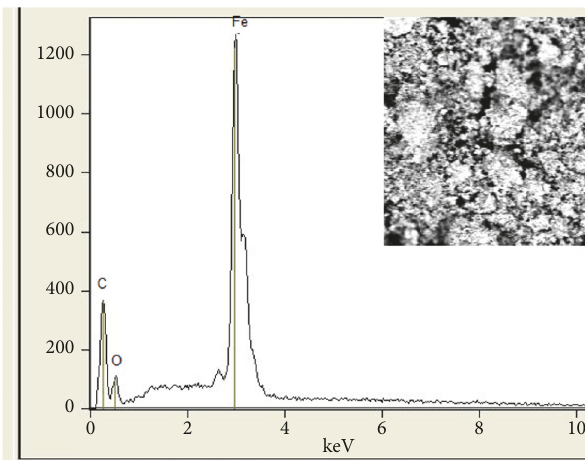
Figure 3: SEM-EDX of Fe 2 O 3 -EC.